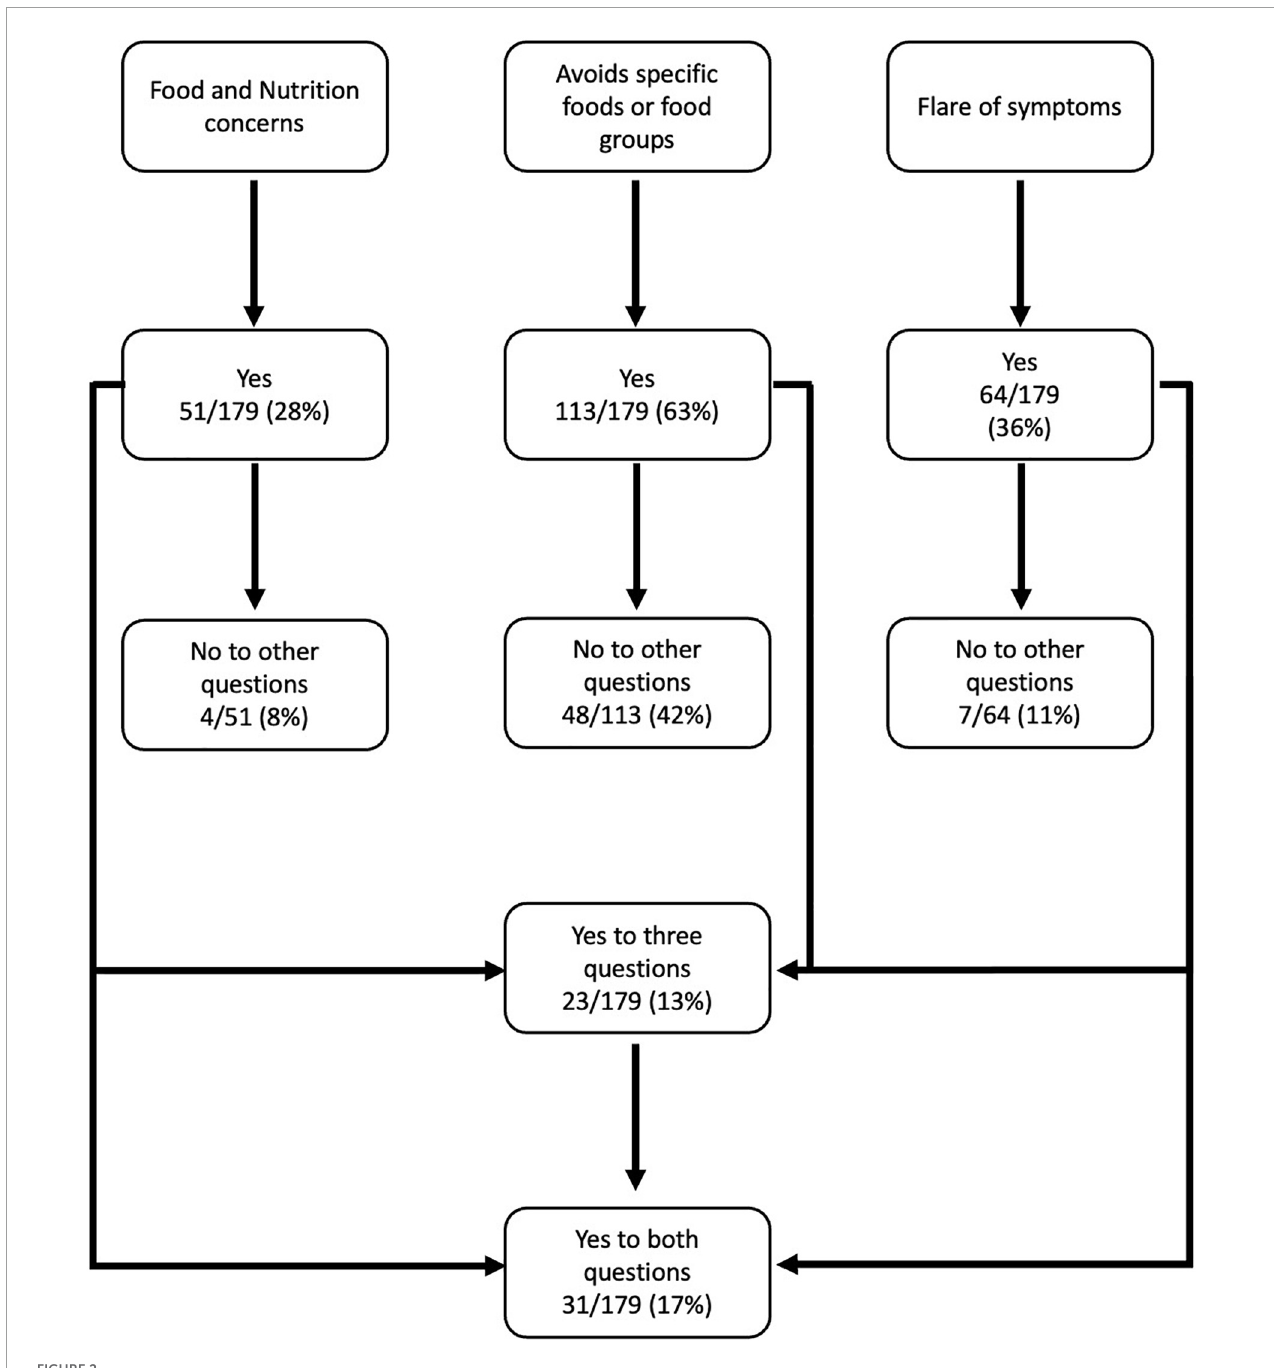
FIGURE2 Novel IBD specific screening